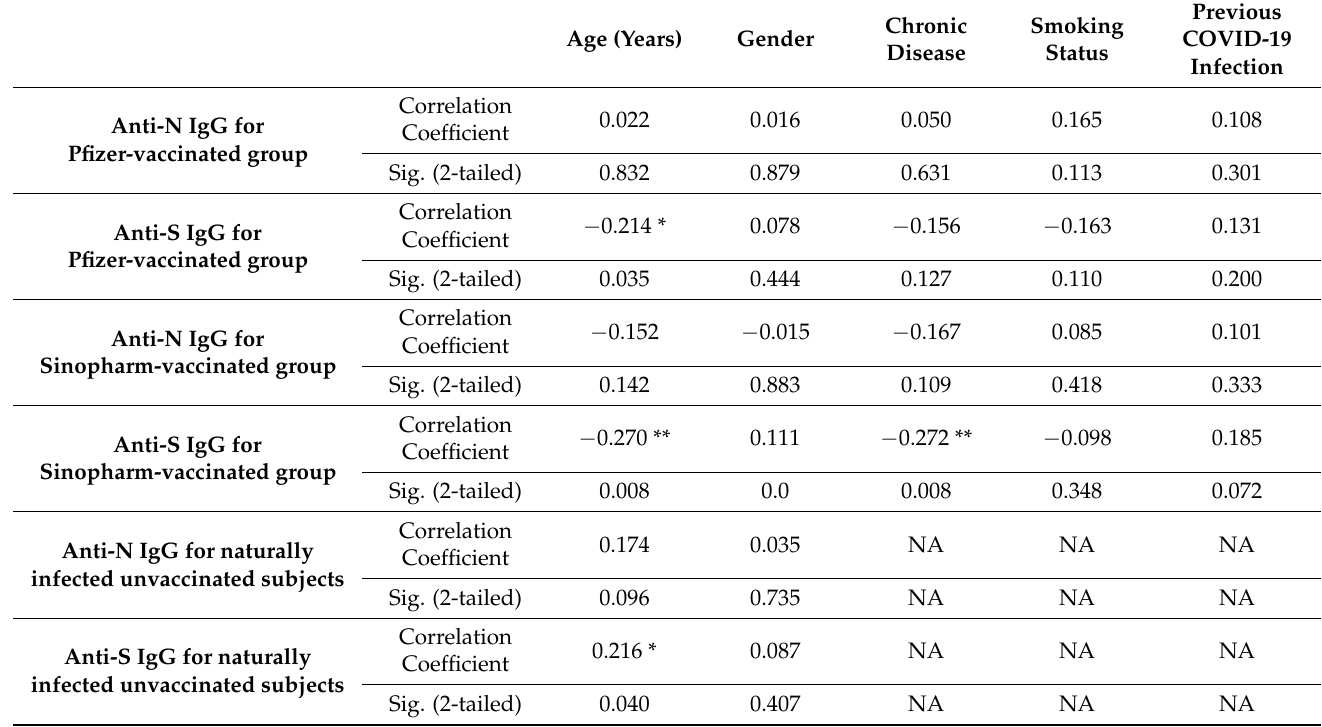
Table 4. Correlations between antibody titers and age, gender, presence of chronic diseases, smoking status, and previous COVID-19 infection.